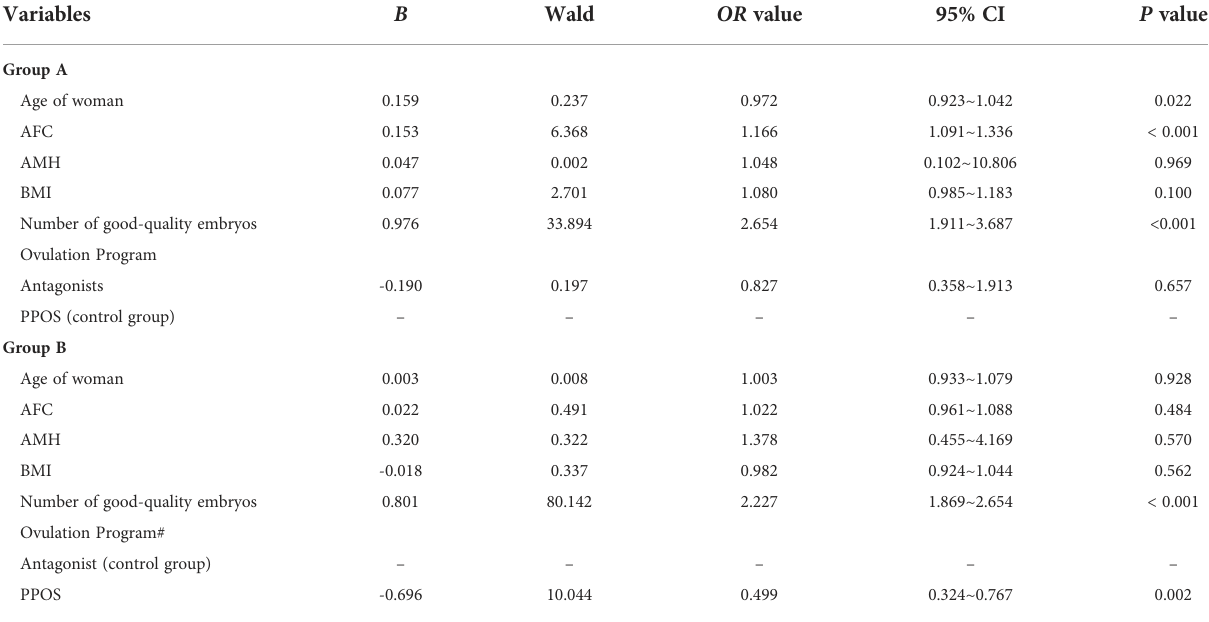
TABLE 5 Multi-factor logistic analysis of cumulative live birth